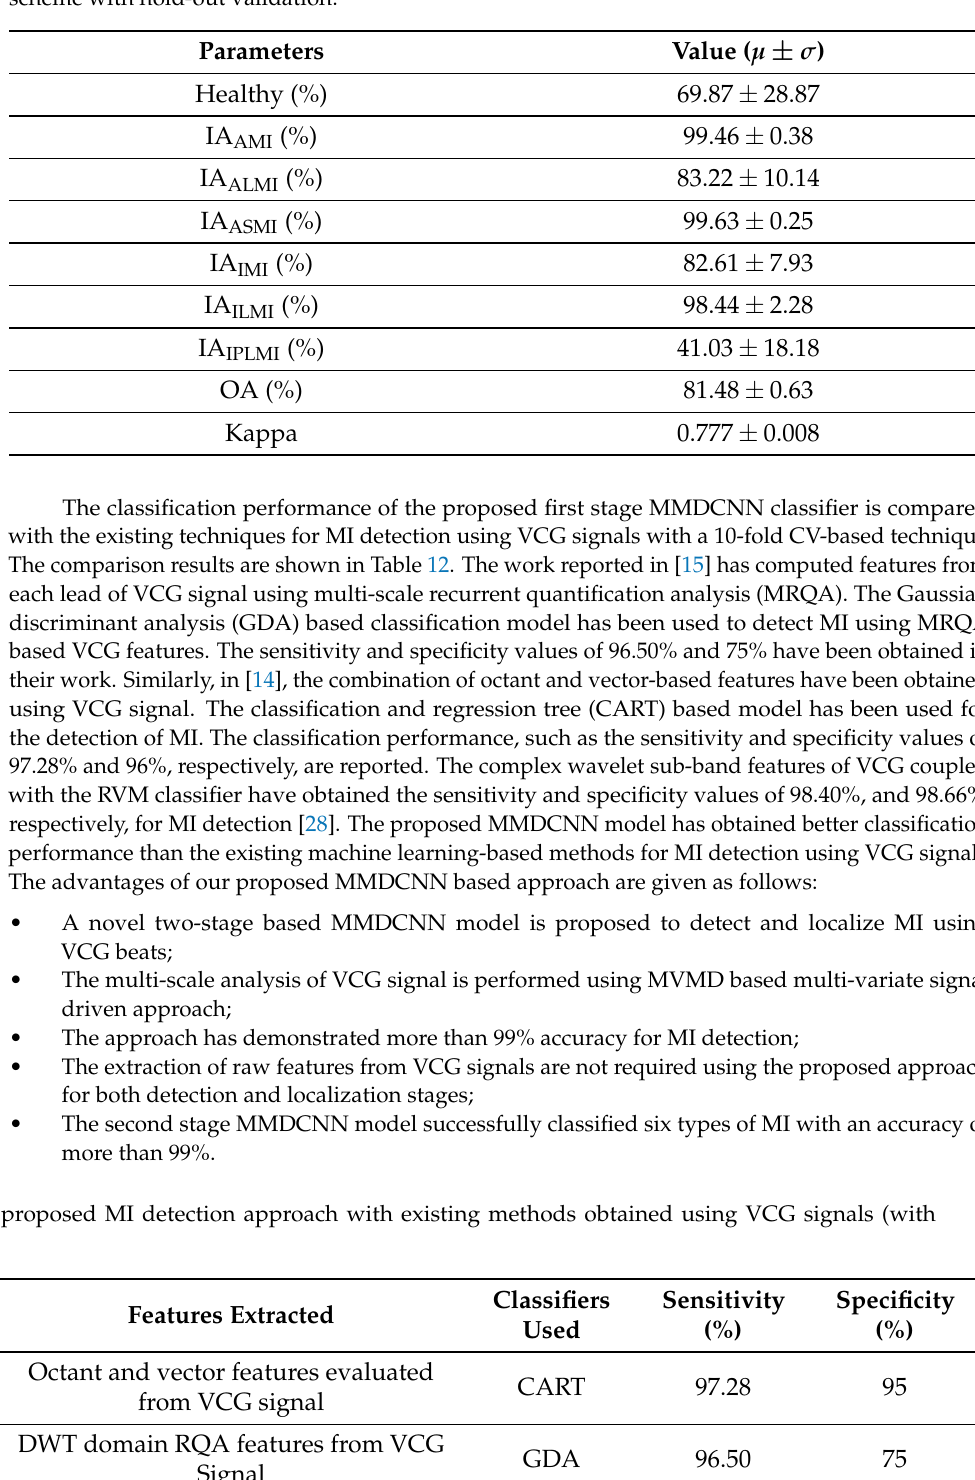
Table 11. Classification results obtained using MMDCNN classifier for seven class classification scheme with hold-out validation.